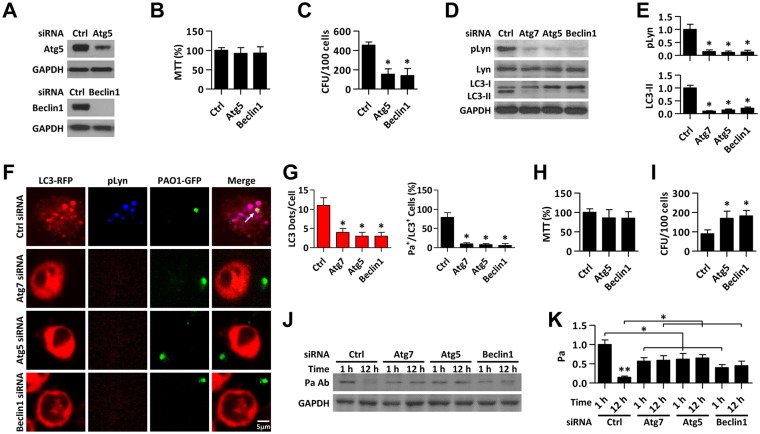
Autophagy is important for Lyn-dependent elimination of Pa in macrophages.(A) MH-S cells were transfected with Ctrl, Atg5 or Beclin1 siRNA for 24 h, respectively. Immunoblotting was performed to verify the knock down of these two genes. (B) After Atg5 or Beclin1 was knocked down, MTT assay was used to determine the cell viability upon PAO1 infection (MOI = 10, 1 h). (C) CFU assay was performed to test the phagocytosis ability from above samples. (D) Cells above were collected and lysed for immunoblotting to measure the phosphorylation level of Lyn. (E) Quantification of pLyn and LC3-II level in D is shown. (F) MH-S cells were transfected with LC3-RFP for 24 h. Cells were infected with PAO1-GFP (MOI = 10, 1 h). Immunostaining was used to detect pLyn. Pa surrounded by LC3 and pLyn was detected by confocal microscope. Scale bar = 5 μm. (G) LC3 puncta in each cell were counted. The percentage of LC3+/Pa+/pLyn+ events (cell with colocalized puncta of LC3-RFP, PAO1-GFP, and pLyn) is shown. Data are derived from 100 cells in each sample. (H) MH-S cells were infected with PAO1 as above. After 1 h, cells were washed and subjected to polymyxin B for another 1 h. 10 h later, cell viability was determined by MTT assay. (I) Clearance assays were performed by counting CFU. (J) MH-S cells were infected with PAO1 for 1 h or 12 h as above. Cell lysates were performed for immunoblotting to test the invaded bacteria using Pa antibody. (K) Quantification of Pa protein in J is shown. All data are representative as means+SD of three independent experiments. One-way ANOVA (Tukey’s post hoc); *, p<0.05; **, p<0.01.